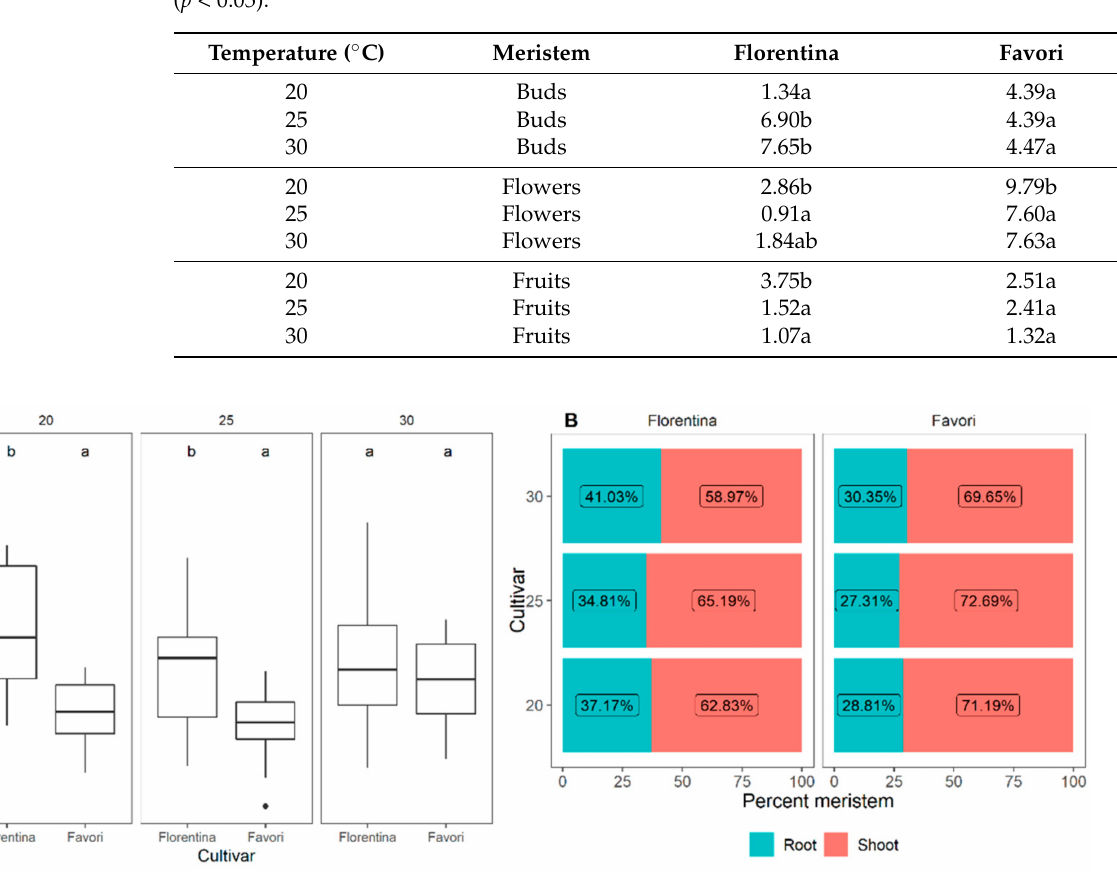
Figure A1. Pairwise comparison of the percentage biomass (%) using least means followed by the same lowercase letter between the cultivars indicate no statistical difference by the Tukey test at 5% of error probability ( p < 0.05) ( A ). Biomass contribution from the shoot and root after between the two strawberry cultivars, ‘Florentina’ and ‘Favori’ after 14 weeks of temperature treatment at 20 ◦ C, 25 ◦ C, and 30 ◦ C in SD ( B